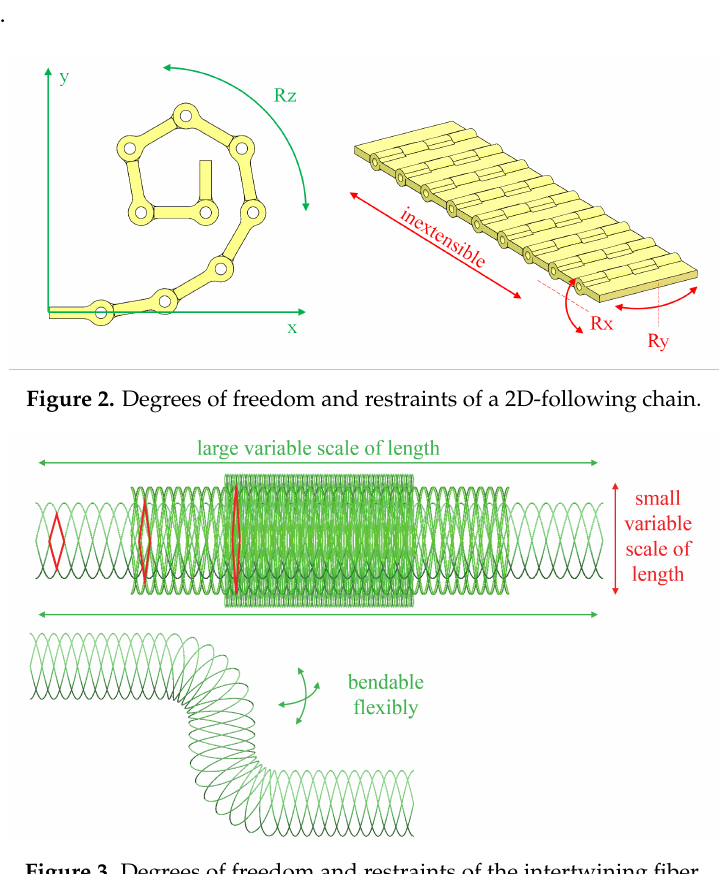
Figure 3. Degrees of freedom and restraints of the intertwining